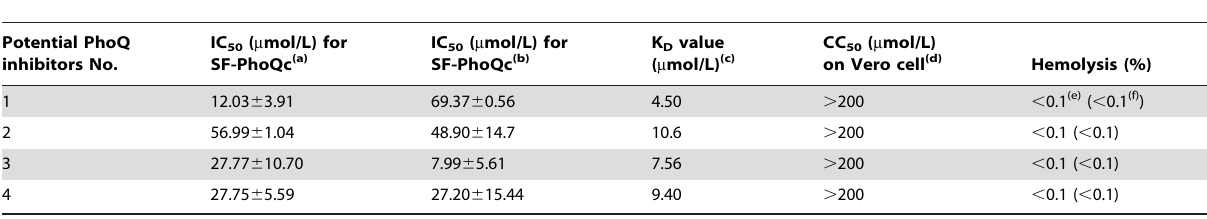
Potential PhoQ inhibitors